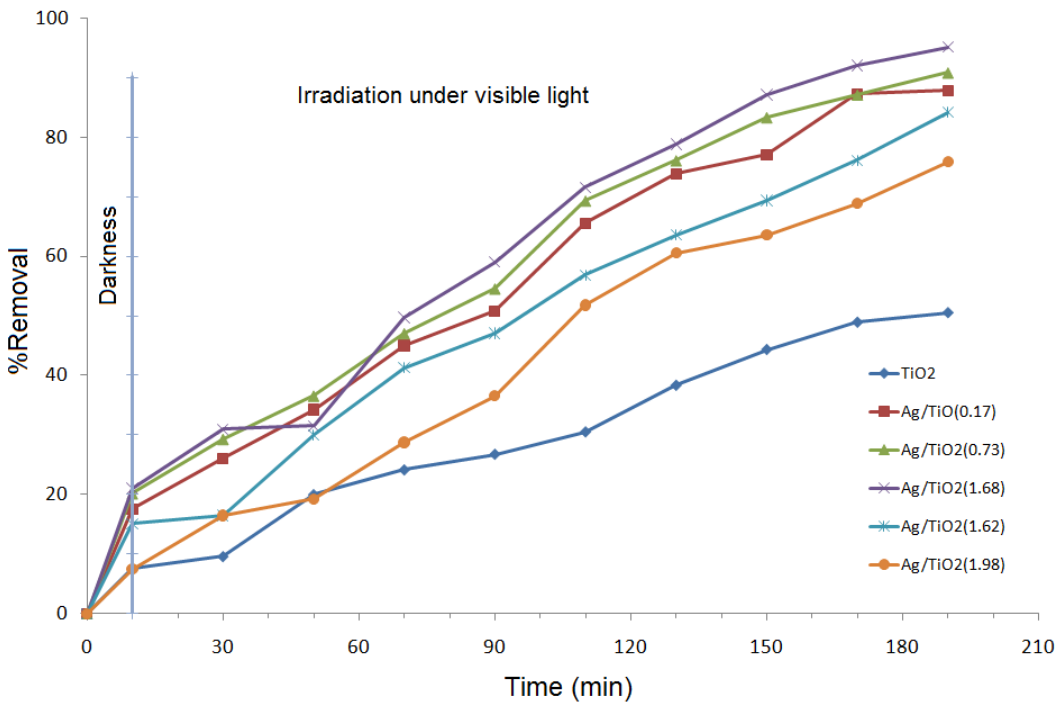
Fig. 4. Photocatalytic degradation of 2,4-DCP in the presence of prepared samples under visible light. (Initial concentration of 2,4-DCP, 40 mg /L; volume, 100 mL; catalyst dosage. 50